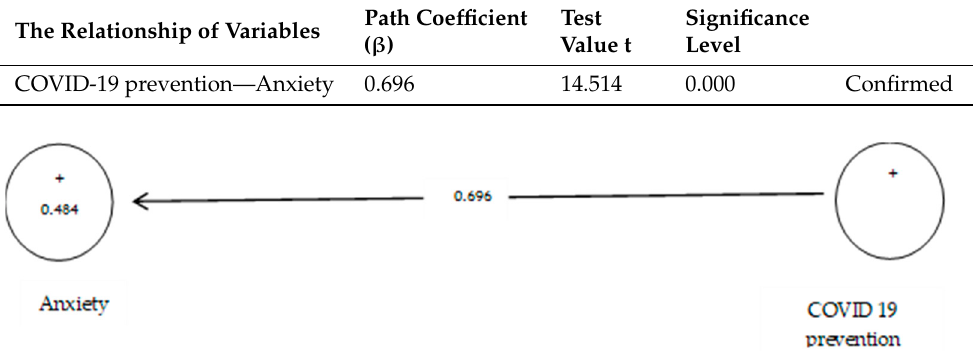
Figure 8. The third sub-hypothesis model includes factor load coefficients.